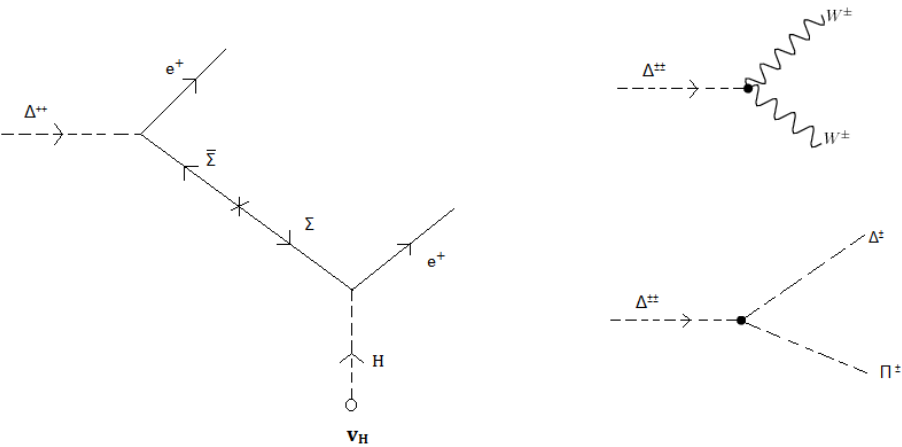
Figure 8 . Feynman diagrams for decay of doubly charged scalar (cid:1) (cid:6)(cid:6) .